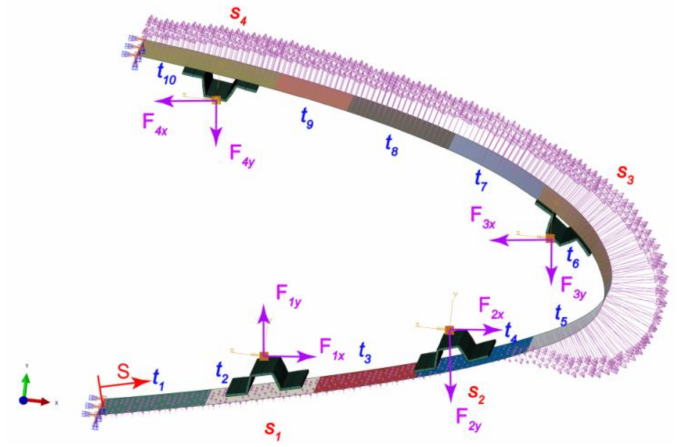
Figure 6. Finite element model of the variable-stiffness compliant